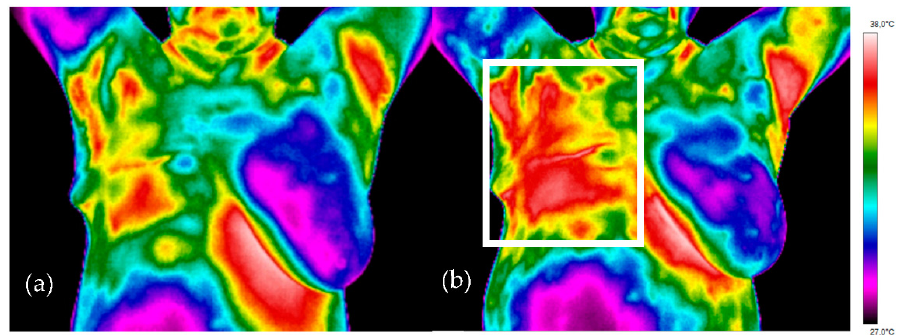
Figure 4. Patient after mastectomy. Treated area after right breast excision ( a ) thermogram before radiotherapy treatment. ( b ) thermogram after three weeks of radiotherapy